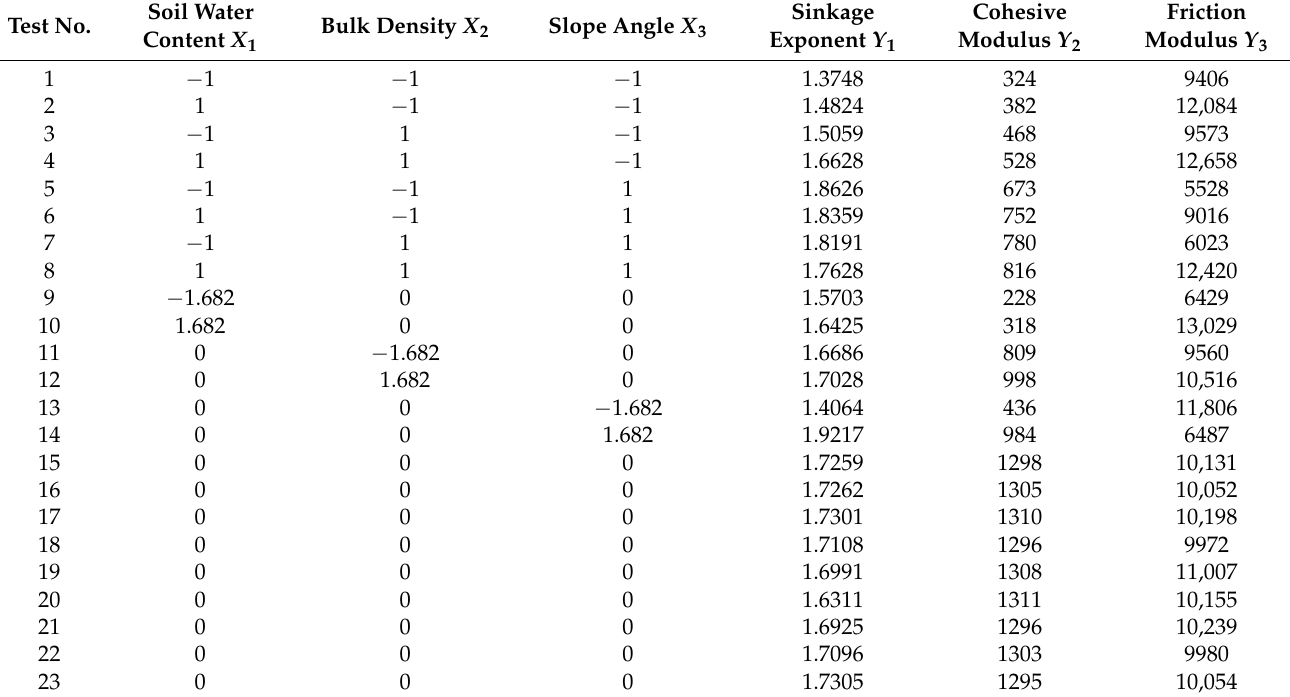
Table 5. Results of soil sinkage parameter